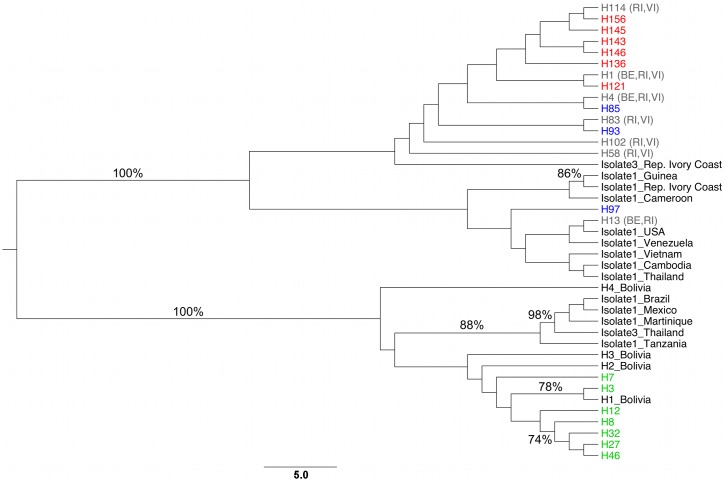
Neighbor-joining (NJ) tree of Ae. aegypti haplotypes using HKY + I + G nucleotide substitution model.Green, blue and red taxa indicate haplotypes found exclusively in Colombian cities of BE, RI and VI, respectively. Grey taxa indicates haplotypes found in more than one city (see S4 Table). Node support bootstrap values > 70% are shown on the branch.